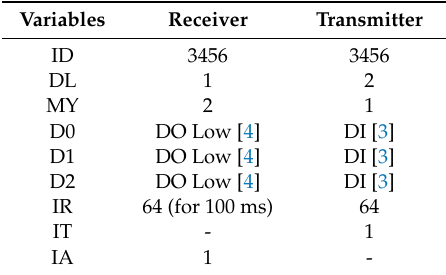
module; MY sets the 16-bit source address for the transmitter XBee module; D0, D1, and D2 are digital